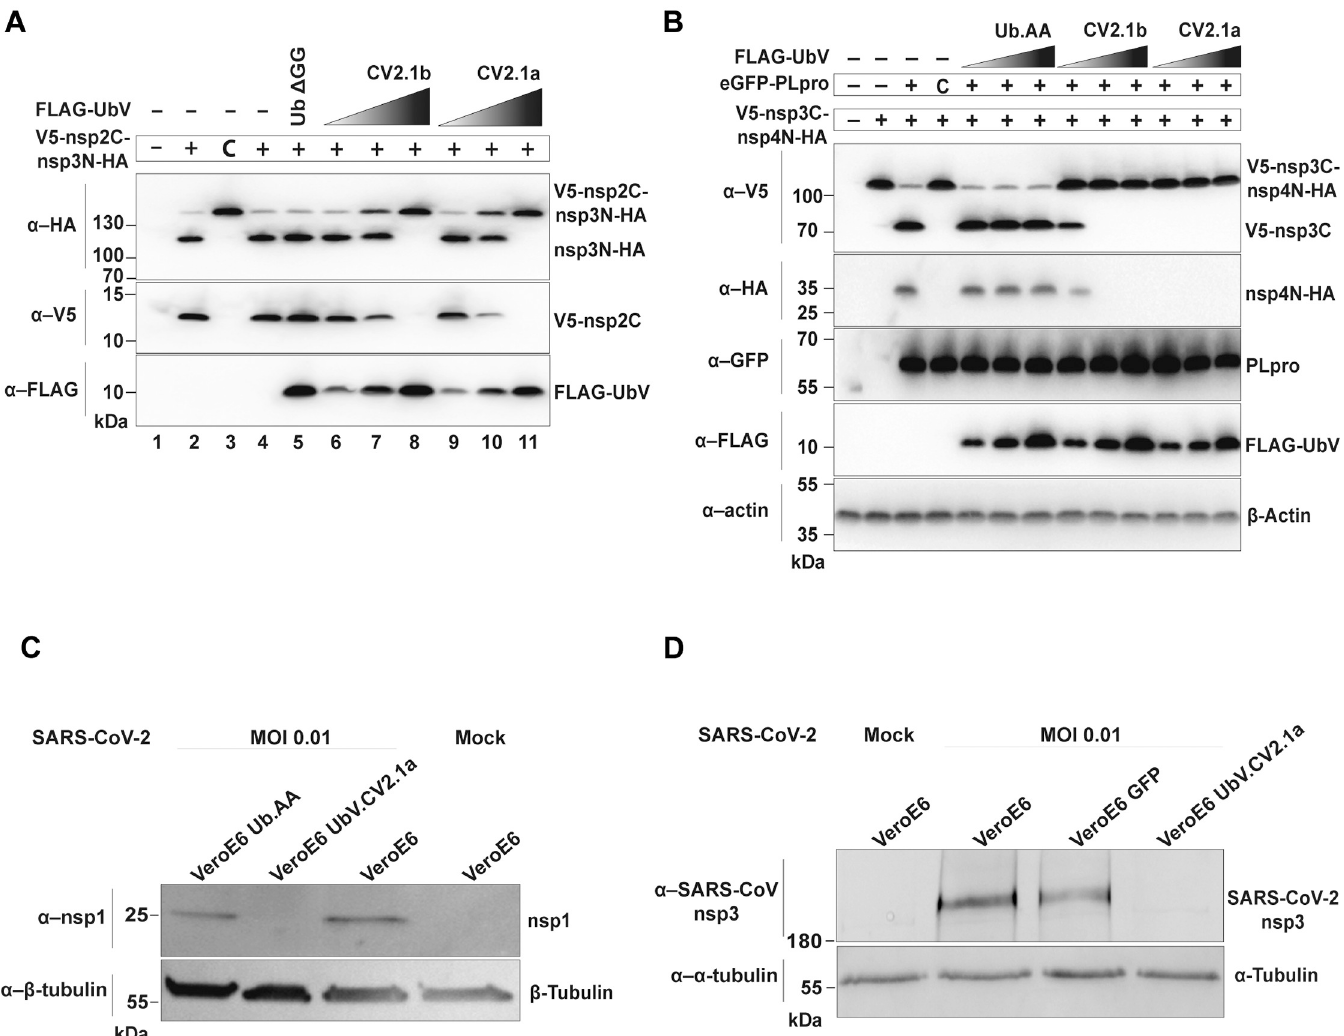
Fig 3. UbVs inhibit proteolytic activity of SARS-CoV-2 PLpro in vitro and in cell culture. (A) The ability of UbV.CV2.1a and 1b to inhibit proteolytic activity of SARS-CoV-2 PLpro was assessed in vitro at increasing concentrations. A construct encoding V5-nsp2C-nsp3N-HA—N-terminal V5-tagged and C-terminal HA-tagged nsp2C-nsp3N (including the PLpro domain)—was transcribed and translated in vitro in the presence of 0.1, 1.0, or 10 μ M UbV.CV2.1a or 1b for 2 hours at 37˚C. Western blotting using the indicated antibodies was used to detect the presence of N-terminal V5-tagged nsp2C and C-terminal HA-tagged nsp3N cleavage products. (B) Inhibition of proteolytic activity of SARS-CoV-2 PLpro by UbVs was examined in transiently transfected HEK293T cells. N-terminal V5-tagged and C-terminal HA- tagged nsp3C-nsp4N (V5-nsp3C-nsp4N-HA) that excludes the PLpro domain was co-expressed with GFP-tagged SARS-CoV-2 PLpro (wt or the catalytically inactive C111A mutant ‘C’) and FLAG-UbV.CV2.1a or 1b (with increasing amounts of 0.5, 0.75, and 1.0 ug). Cells were lysed 20 hours post transfection and analyzed by western blotting with the indicated antibodies to detect generation of N-terminal V5-tagged nsp3C and C-terminal HA-tagged nsp4N cleavage products. (C) Effect of